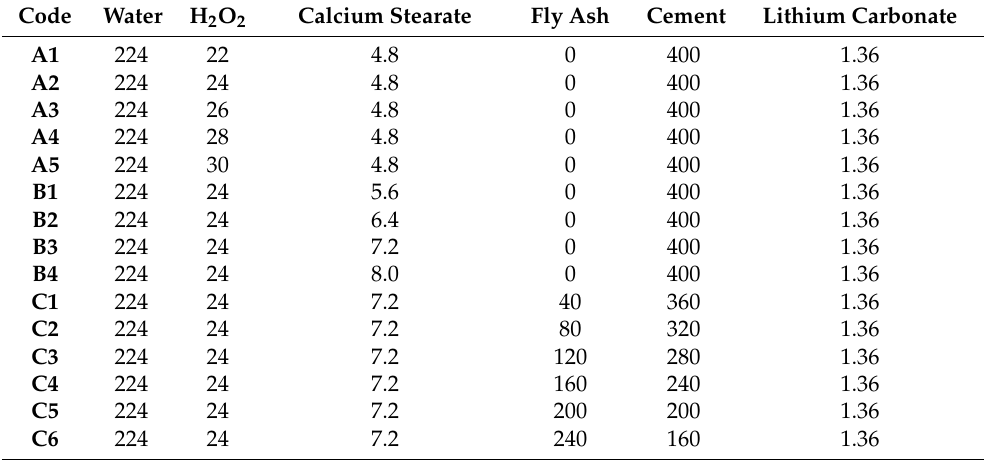
Table 3. Proportions of different mixtures (kg/m 3